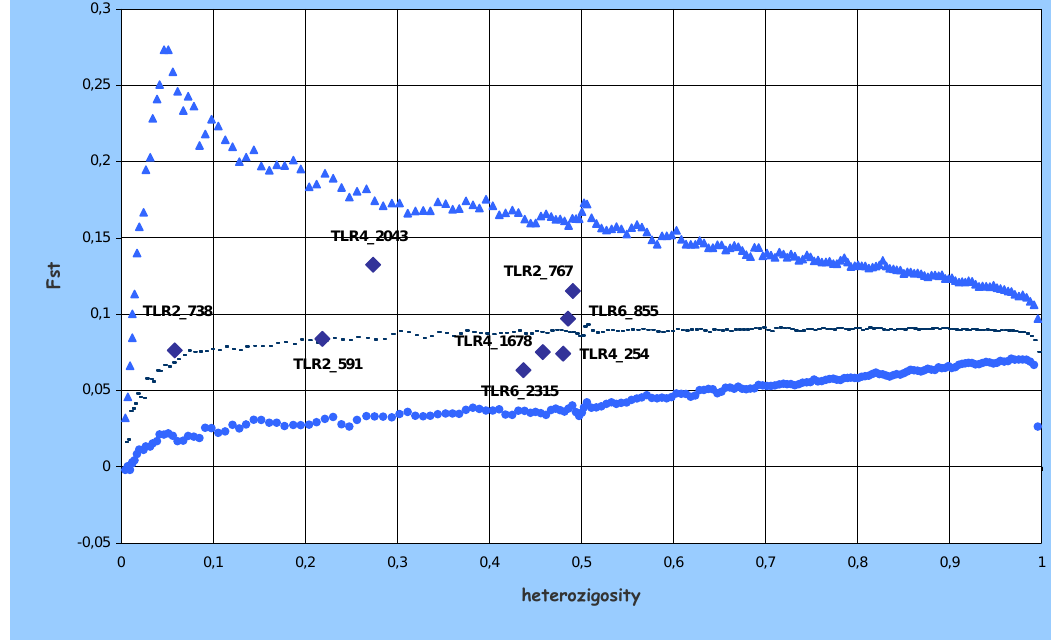
Figure 1. Upper (▲) and lower (●) confidence limits of 95% quantiles; median (-) of 200,000 replications of expected Fst and heterozygosity using the coalescent